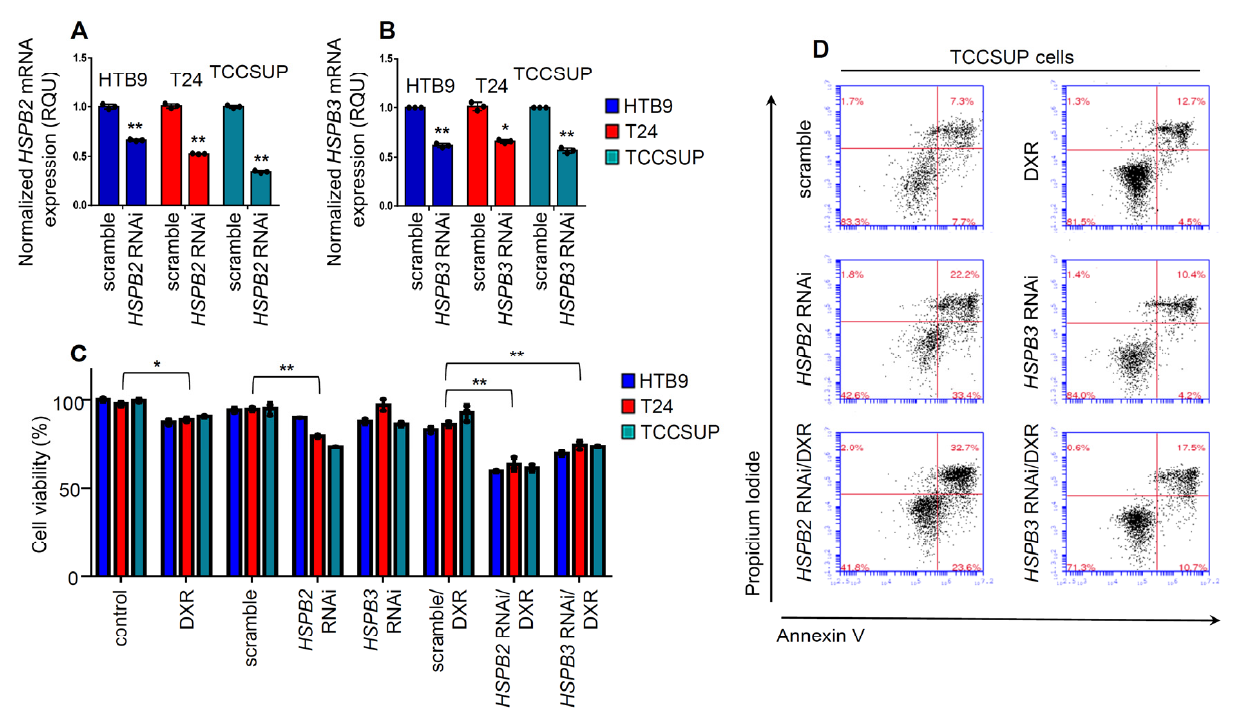
Figure 6. ( A , B ) Relative HSPB2 ( A ) and HSPB3 ( B ) mRNA expression levels in the indicated BlCa cell lines after transfection with the shown RNAi oligonucleotides or a non-targeting pool (scramble) for 48 h. ( C ) Cell viability (MTT assay) of BlCa cell lines being treated with RNAi oligonucleotides or a non-targeting pool (scramble) for 48 h and then exposed to DXR (200 nM) for 24 h. ( D ) Flow Cytometry after transfecting the TCCSUP cell line with HSPB2 or HSPB3 RNAi oligonucleotides or a non-targeting pool (scramble) for 48 h and then exposed to DXR (200 nM) for 24 h. The percentages of Annexin V- and PI- positive cells are indicated. In ( A , B ) control samples values were set to 1; in ( C ) control samples values were set to 100. p -value was calculated using an unpaired t -test. Bars, ± SD; * p < 0.05; ** p < 0.01.